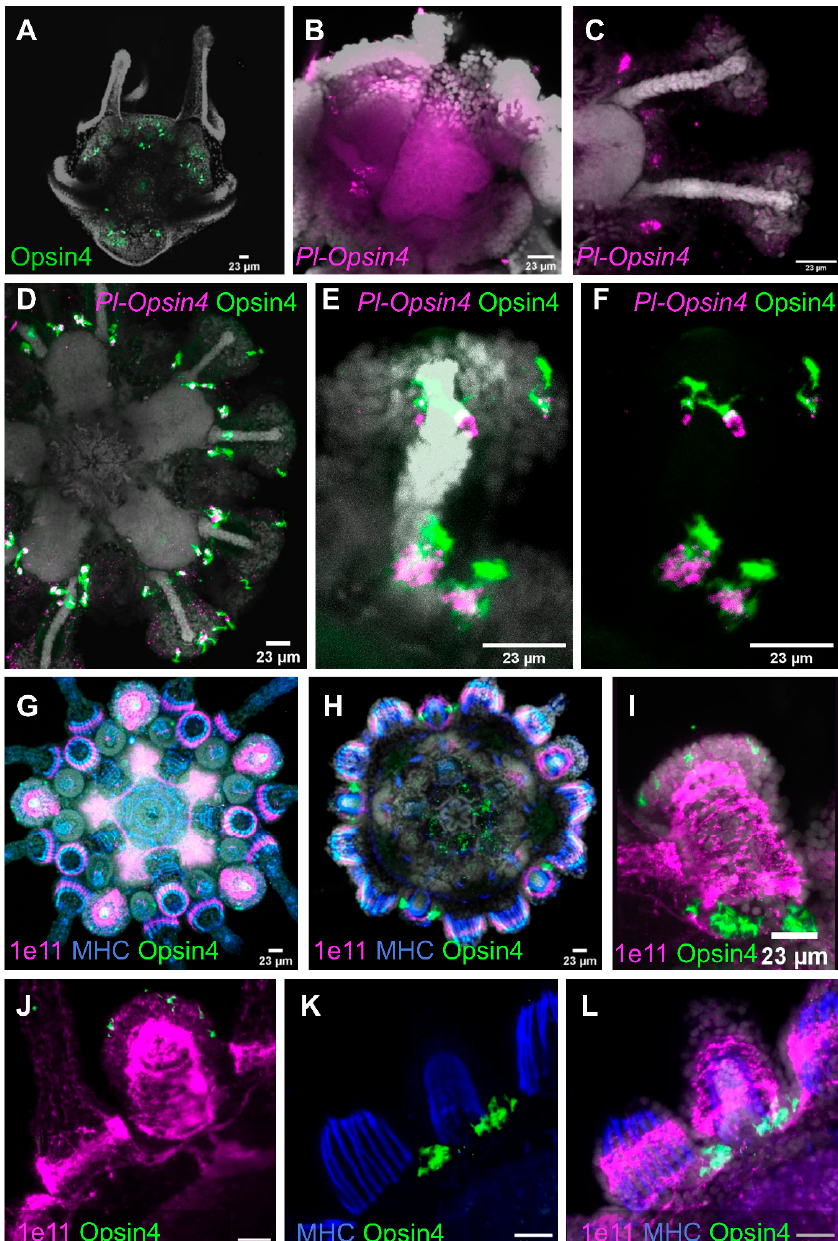
Figure 4. Immunolocalization (IHC) of sea urchin Opsin4 and expression of opsin4 mRNA (FISH) in mature rudiments and juveniles. ( A ) Immunohistochemical detection of Opsin4 at the 8-arm mature rudiment stage. ( B ) FISH using an antisense probe against Pl-opsin4 at the mature rudiment stage. ( C ) Immunohistochemical detection of Opsin4 protein at juvenile stage. ( D – F ) FISH using a specific antisense probe for Pl-opsin4 paired with IHC for Opsin4 protein at juvenile stage. ( G , H ) IHC detection of antigens indicative of the nervous system (1e11), musculature (MHC) and PRCs (Opsin4). ( G , H ) are a result of compilation of different stacks corresponding to the same individual. ( I ) Podium close-up showing the immunolocalization of Opsin4 and the pan-neuronal marker 1e11. ( J – L ) IHC detection of antigens indicative of the nervous system (1e11), musculature (MHC) and PRCs (Opsin4) focusing on a podium and the surrounding spines. DAPI was used to visualize nuclei (gray). Orientation: ( A ), the specimen is viewed from the top; ( B ), the specimen is viewed from the side; ( D , G , H ), juveniles are in oral